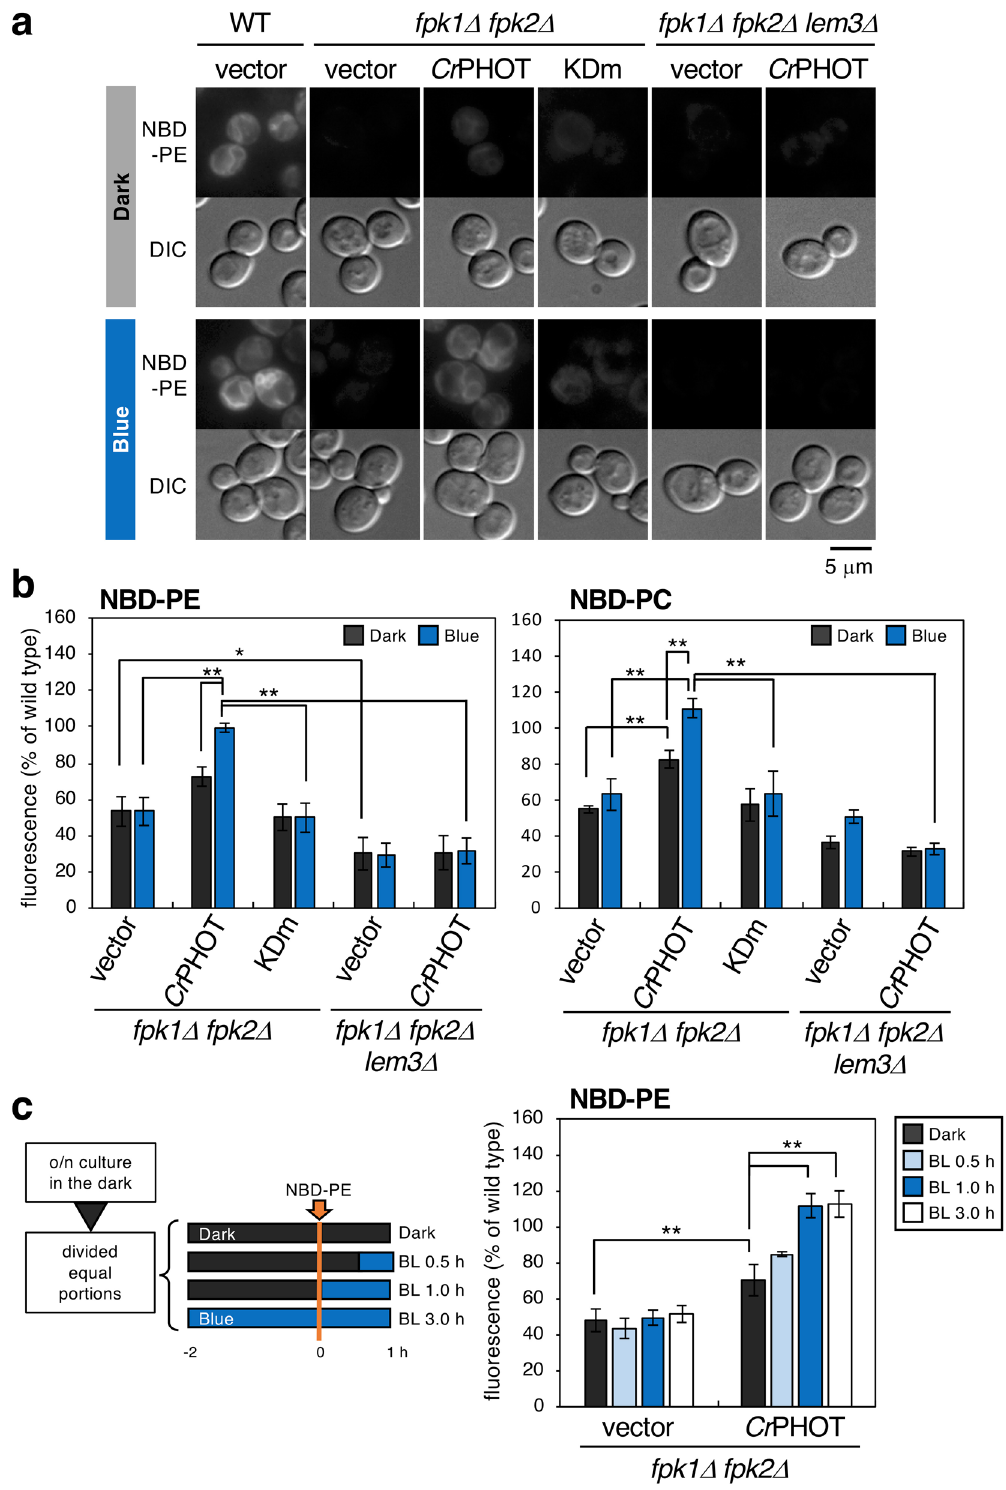
cells expressing the K-fragment regardless of light irradiation (77.2% in the dark and 86.7% under BL), while prolonged polarization was observed even under BL in KDm- (Fig. 4c; 19.3% in the dark and 25.0% under BL, Fig. 4d) or LOV1/2 m-expressing cells (Fig. 4c; 24.7% in the dark and 46.6% under BL; Fig. 4d). These results suggest that light can regulate cell polarity switching in a Cr PHOT kinase activity-dependent manner. Light regulates endocytic recycling to the TGN in the CrPHOT system. Dnf1p/Dnf2p-Lem3p and Fpk1p/Fpk2p, redundantly with Drs2p-Cdc50p, regulate endocytic recycling. The lem3 Δ or fpk1 Δ fpk2 Δ